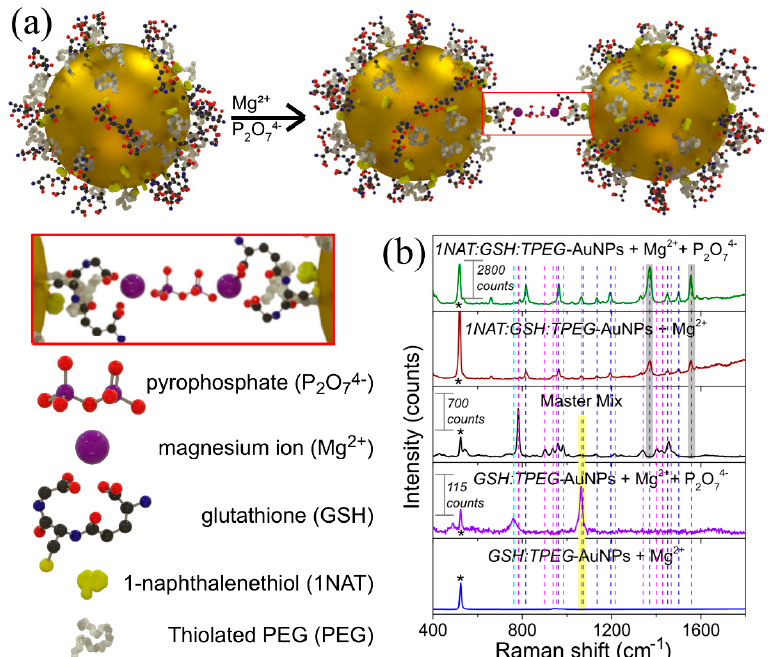
Figure 2. ( a ) Schematic illustration of the mechanism of detection of DNA by LAMP using an indirect SERS method. In this indirect method, the SERS signal comes from a Raman reporter molecule, 1NAT (yellow structure on AuNPs in the scheme ( a )) in this manuscript. Thus, the SERS signal of 1NAT is directly proportional to the 14 nm-AuNPs aggregation triggered by the complexation of the carboxylic group of GSH (molecular structure with red, black, blue and yellow atoms represent oxygen, carbon, nitrogen and sulfur, respectively) that is attached on Au surface and pyrophosphate (molecular structure which purple and red atoms represent phosphor and oxygen, respectively) generated during LAMP reaction with magnesium ions (purple sphere in the scheme). In LAMP, the pyrophosphate ions are produced during DNA amplification because pyrophosphate is released from dNTP as a by-product. In the design of multifunctional AuNPs thiolated poly(ethylene glycol) (TPEG; white molecule in the scheme) was included to avoid the magnesium-related aggregation, increasing the colloidal stability of 1NAT:GSH -functionalized AuNPs in presence of magnesium ions. Illustration inside the red rectangle represents a zoom-in of the Au-GSH:Mg:P 2 O 7 :Mg:GSH-Au complex formed. ( b ) Aggregation behavior of AuNPs functionalized either GSH:TPEG or 1NAT:GSH:TPEG at 5 mM TRIS buffer pH 8.5 and 8 mM Mg 2+ and in absence or presence of potassium pyrophosphate (P 2 O 74 − ) at concentration of 6 µM. The SERS spectra in presence of pyrophosphate show clearly the either 1NAT (green spectrum) or GSH (purple spectrum) characteristic peaks due to the formation of AuNPs aggregates triggered by the complexation of GSH-attached AuNPs (0.32 mM of Au) with Mg 2+ and pyrophosphate ions. This aggregation improved the resonance of LSPR with the selected 785 nm laser line. In absence of pyrophosphate ions, the SERS signal was either null for GSH or lower for 1NAT due to the AuNPs being stable in presence of magnesium ions (blue and dark red spectra, respectively). Despite both types of multifunctional AuNPs work using this SERS strategy, the high Raman signal (back spectrum) acquired from the master mix used in LAMP (mainly from dNTPs) interferes enormously when GSH is used as SERS reporter. Therefore, multifunctional AuNPs that contain 1NAT were selected due to their higher Raman cross section and the fact that one of the SERS band (1368 and 1553 cm − 1 ring stretching) does not overlap with any master mix or PDMS (microfluidic device, see Figure 3b) bands. Characteristic peaks for GSH and 1NAT that do not overlap with the master mix Raman peaks which are labeled with yellow and gray shaded areas, respectively. Dashed lines highlight the position of the Raman peaks corresponding to dNTPs of the master mix (magenta dashed line) and SERS peaks of GSH (cyan dashed line) and 1NAT (blue dashed line). * indicates the Raman peak from the silicon wafer used as substrate for these measurements (520 cm − 1